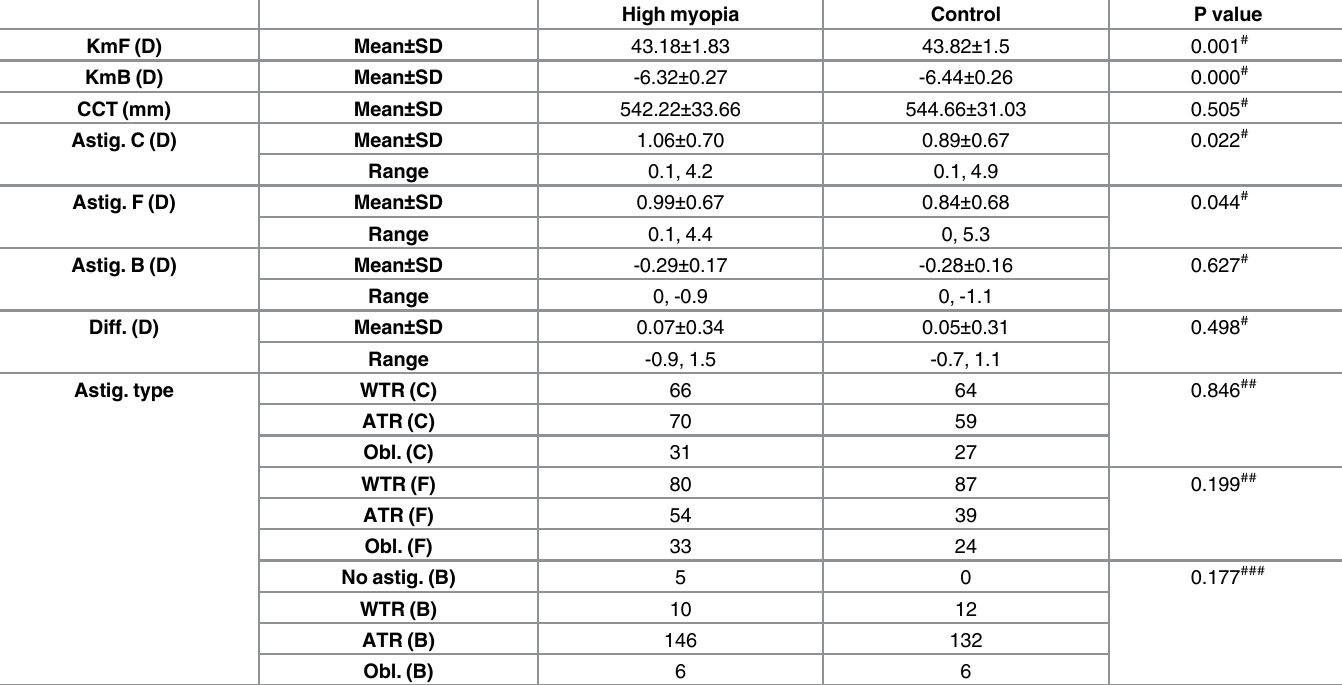
Table 2. Corneal characteristics of the high-myopia and control